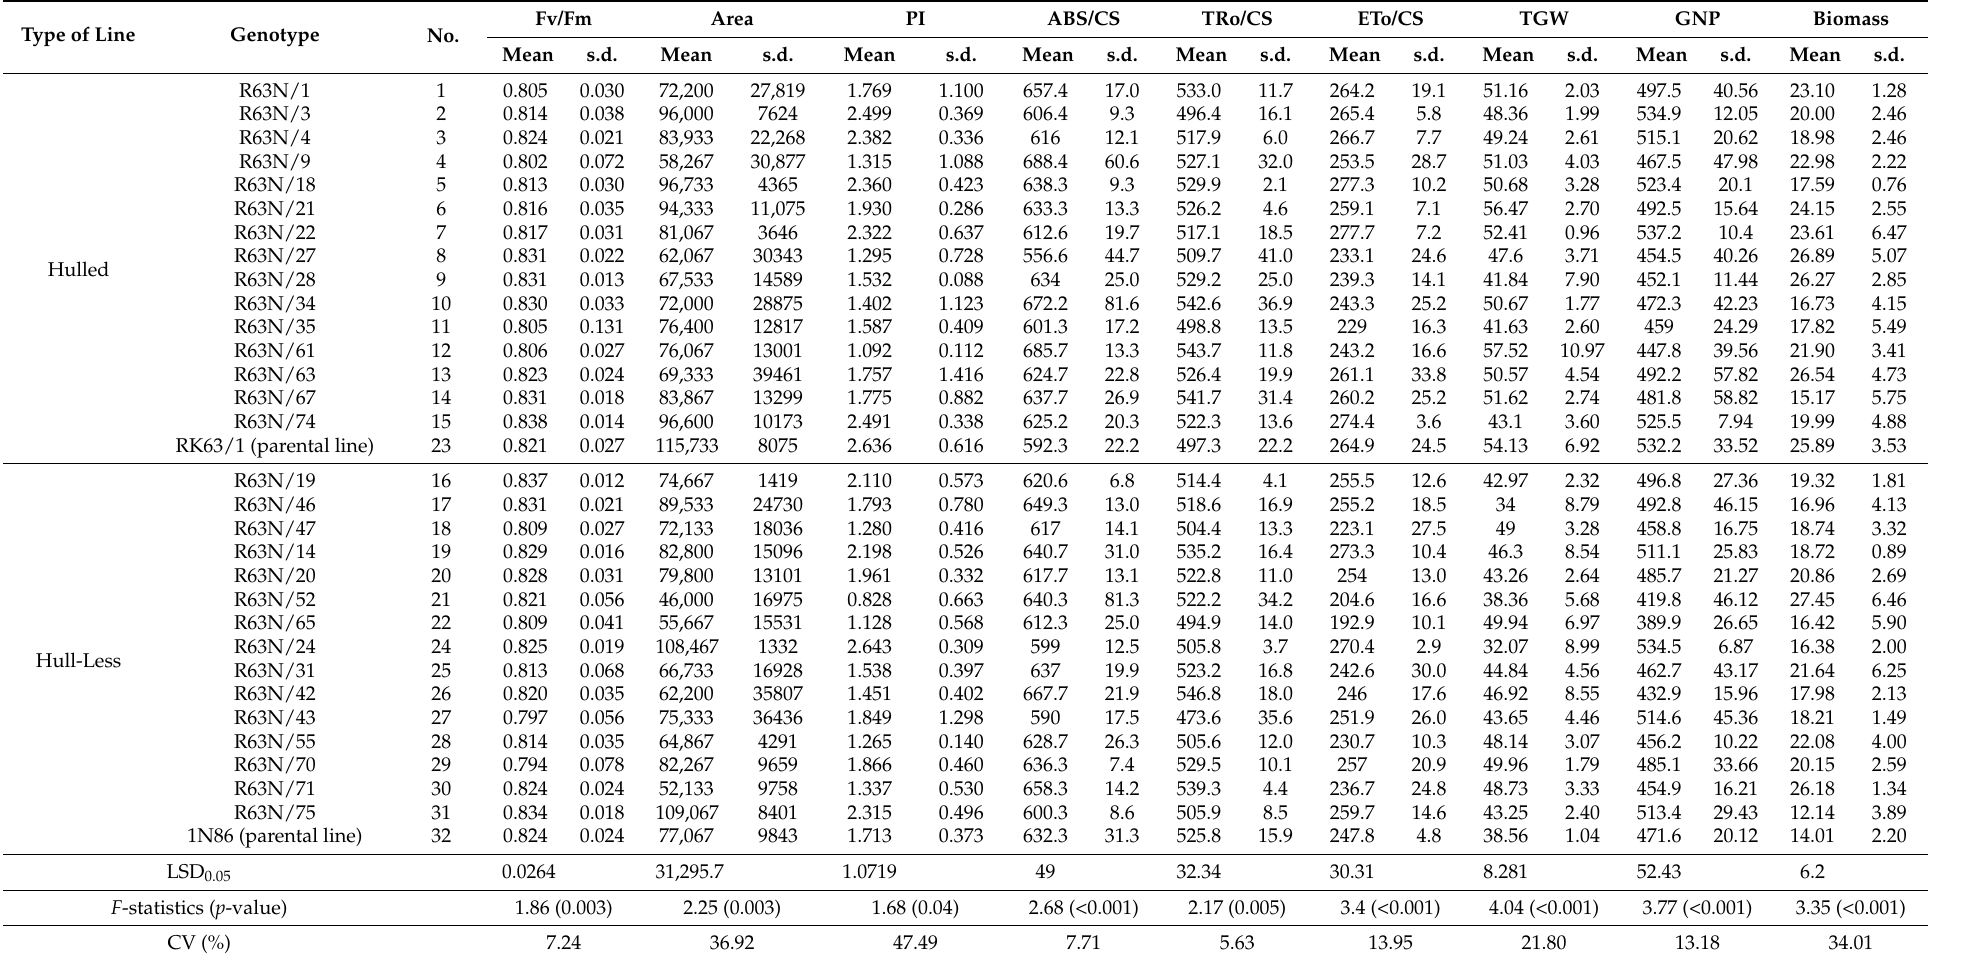
Table 1. The chlorophyll fluorescence indices, yield elements (mean values), standard deviations (s.d.), coefficient of variance CV (%), and F -statistics from one-way analysis of variance for studied variables features of barley DH